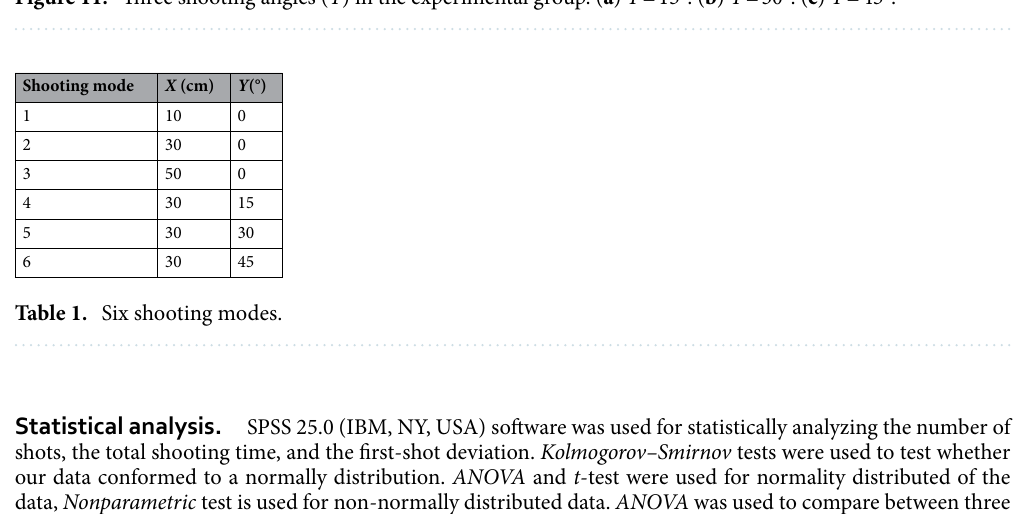
Figure 11. Three shooting angles ( Y ) in the experimental group. ( a ) Y = 15°. ( b ) Y = 30°. ( c ) Y = 45°.